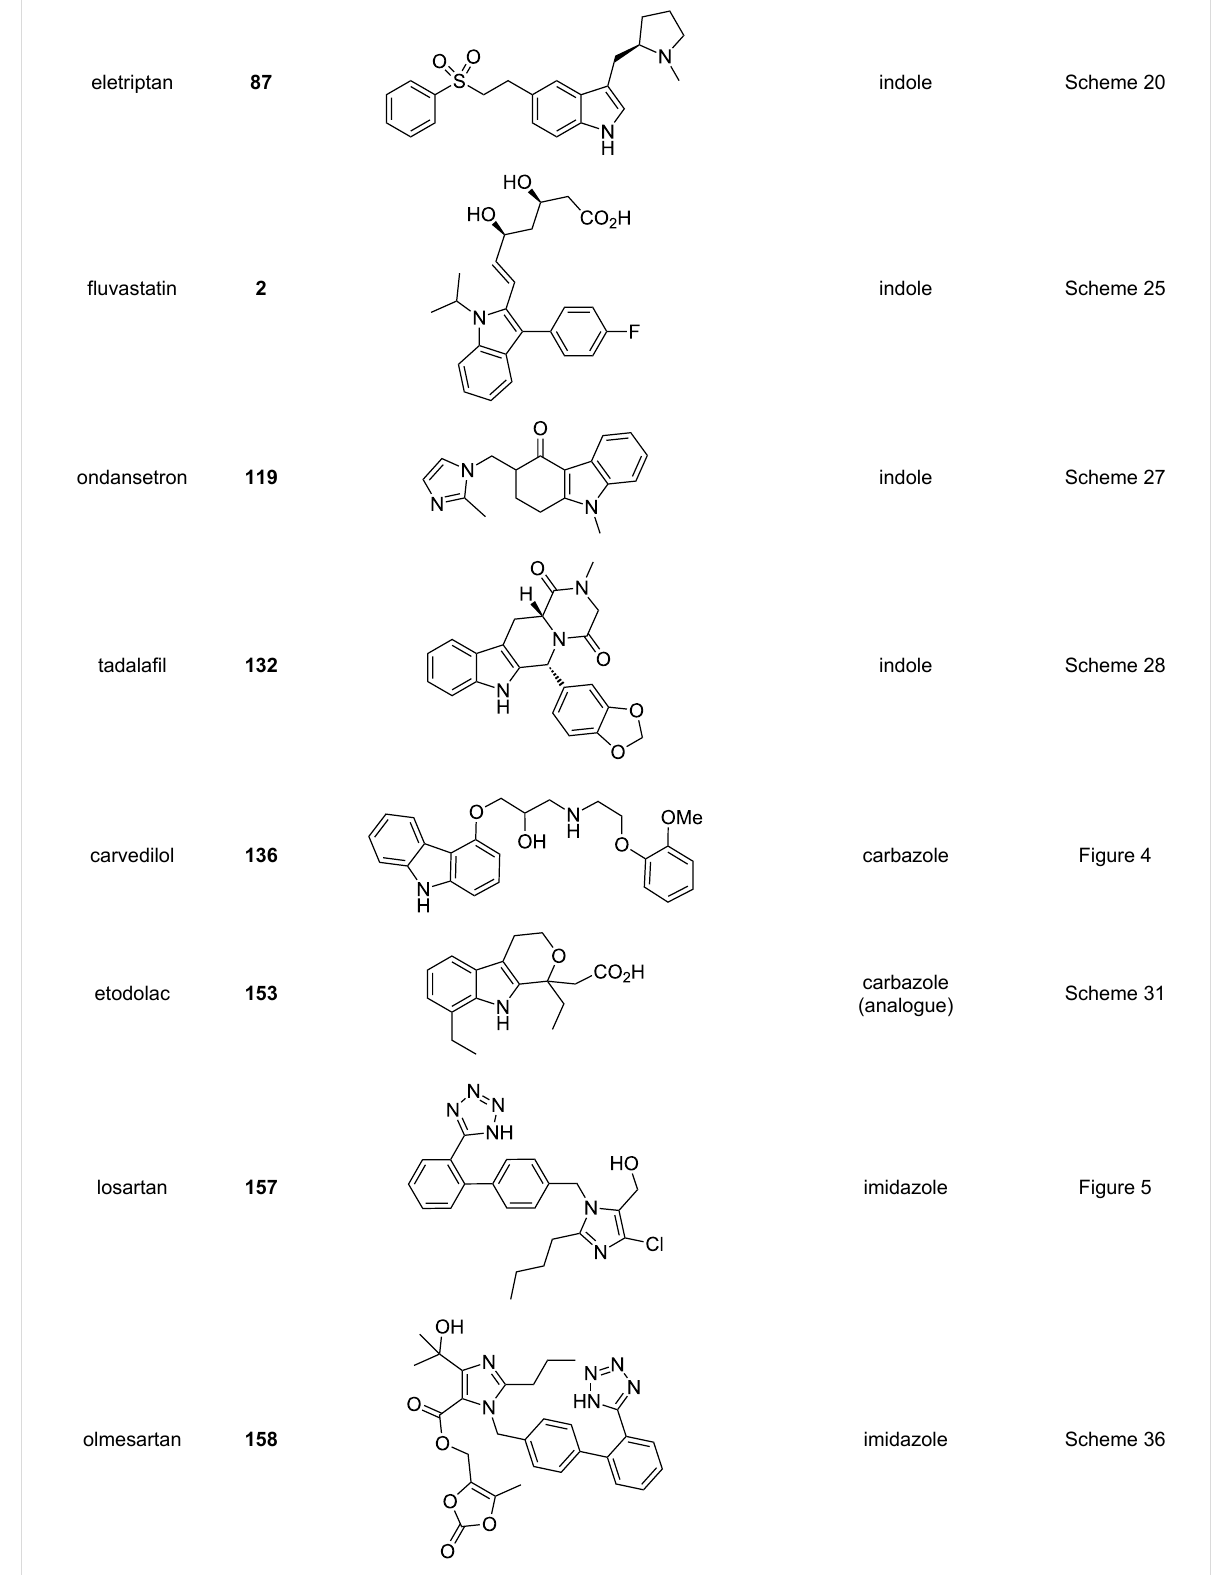
Table 1: Heterocylic structures discussed in this review. (continued)